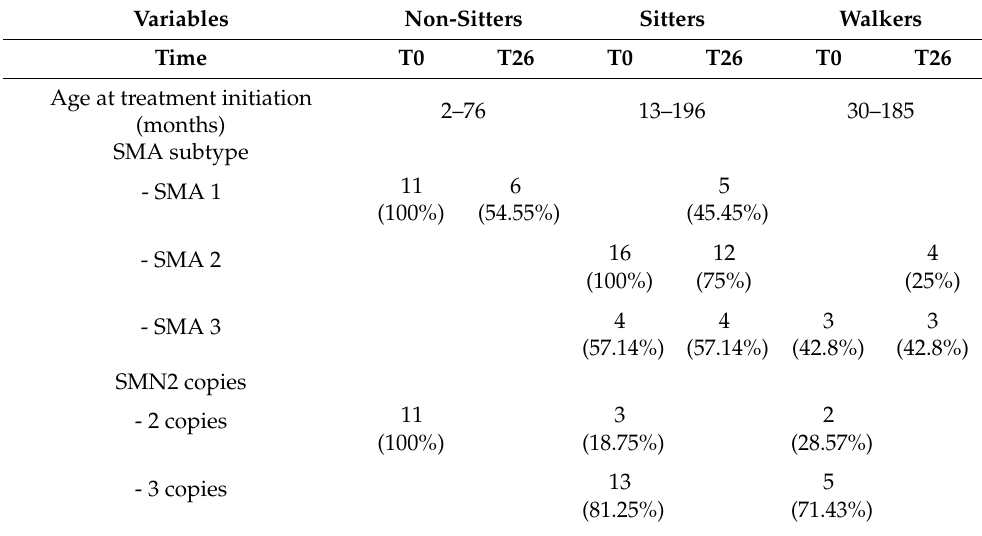
Table 2. Clinical data before and after 26 months of nusinersen in SMA type 1, 2, and 3. Variables